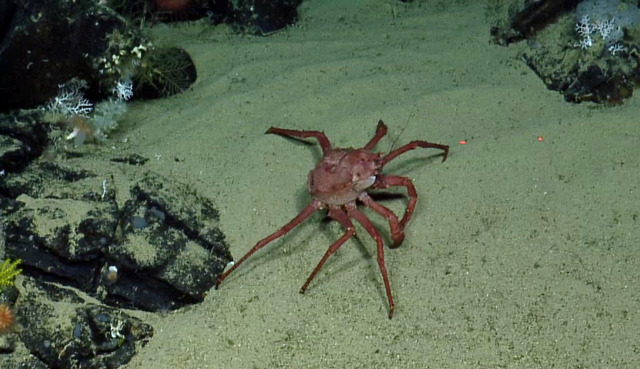

Lithodes
panamensis